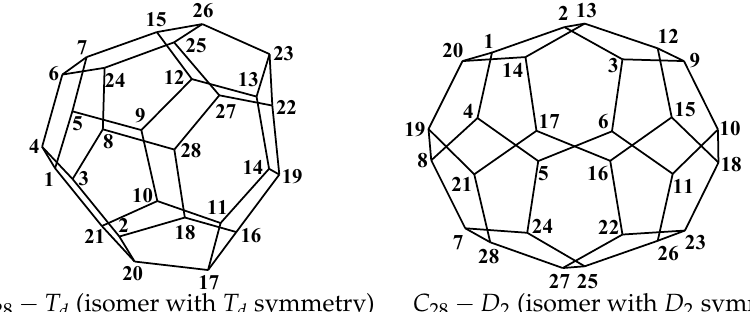
C 28 − T d (isomer with T d symmetry) C 28 − D 2 (isomer with D 2 symmetry) Figure 24. The isomers of C 28 fullerene.